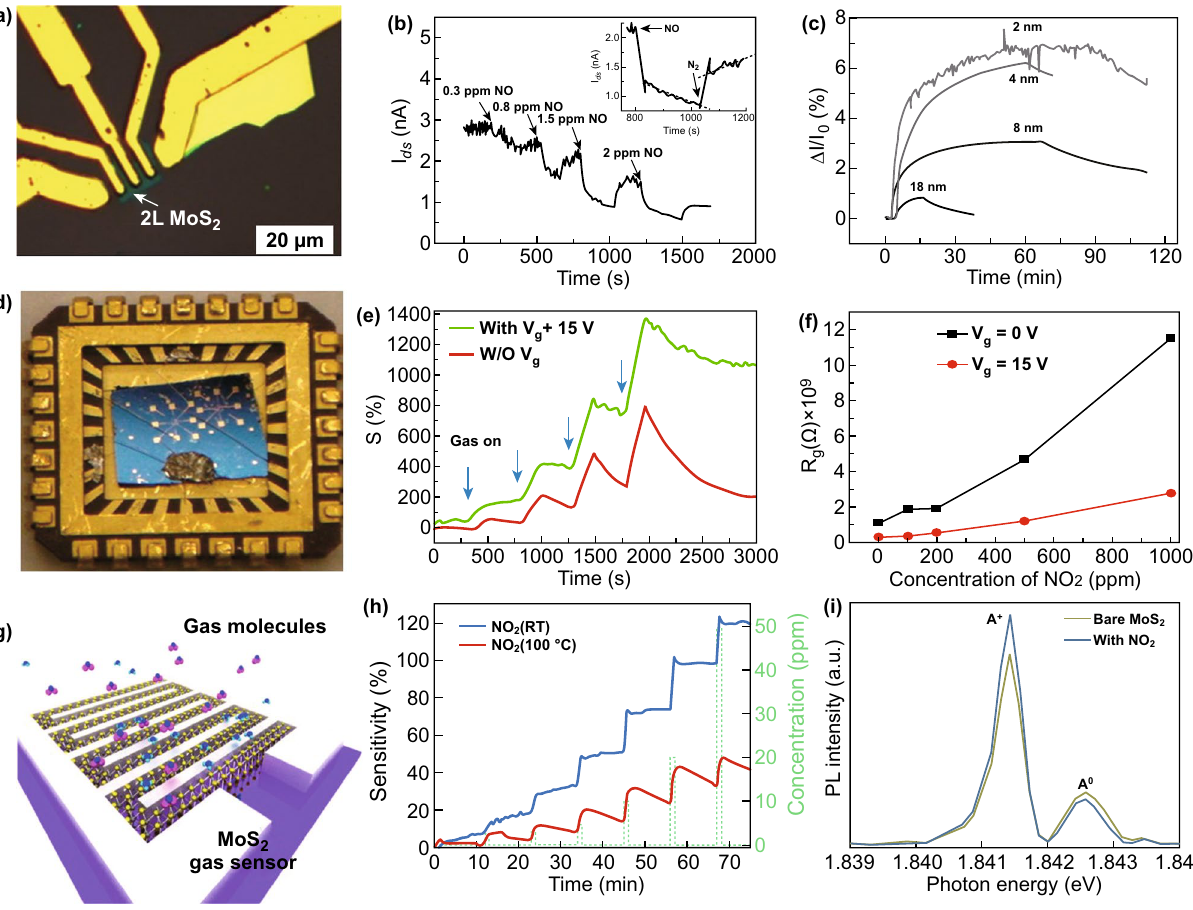
Fig. 10 a Optical image of bilayer MoS 2 -based FET NO sensor. b MoS 2 FET response to different concentrations NO. The inset showed the typical response and recovery of the MoS 2 FET device. Reproduced with permission from Ref. [34]. Copyright (2012) Wiley-VCH. c MoS 2 TFT NO 2 sensor with different thickness MoS 2 flakes. Reproduced with permission from Ref. [42]. Copyright (2012) Wiley-VCH; d optical image of MoS 2 device mounted on a chip. e NO 2 response for the bi and five-layer MoS 2 devices at different gate voltages. f Theoretically calculated resistance variation with different gate voltages. Reproduced with permission from Ref. [17]. Copyright (2013) American Chemical Society. g Device schematic of atomic layer MoS 2 -based sensing device. h Response of NO 2 at RT and at moderate temperature of 100 °C. i Change in the low energy PL peak due to